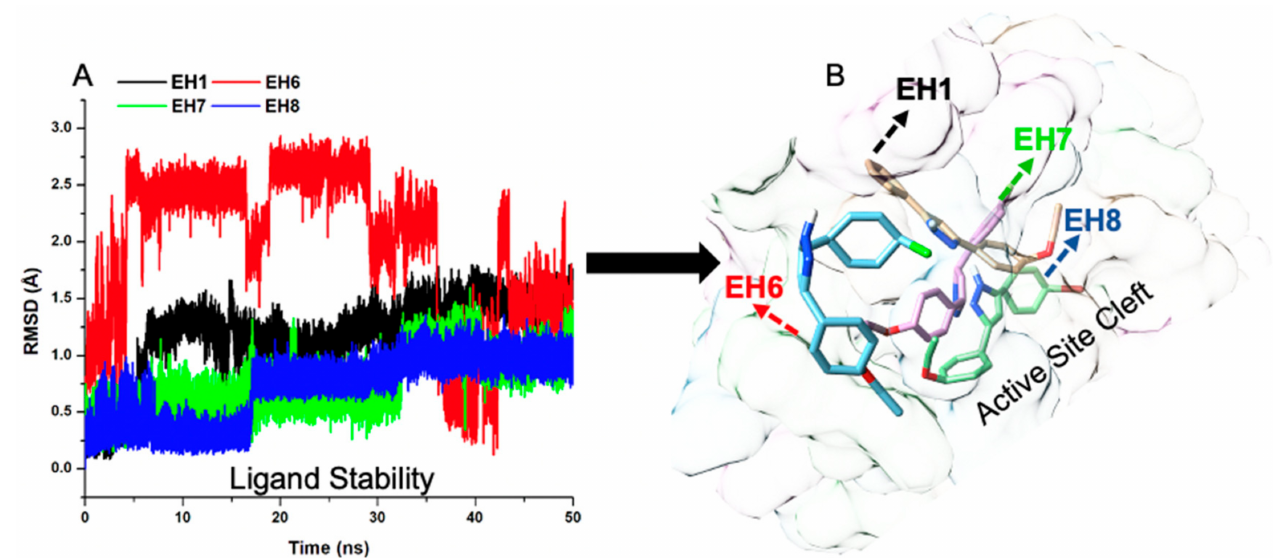
Figure 6. Stability plot of compounds EH1 , EH6 , EH7 , and EH8